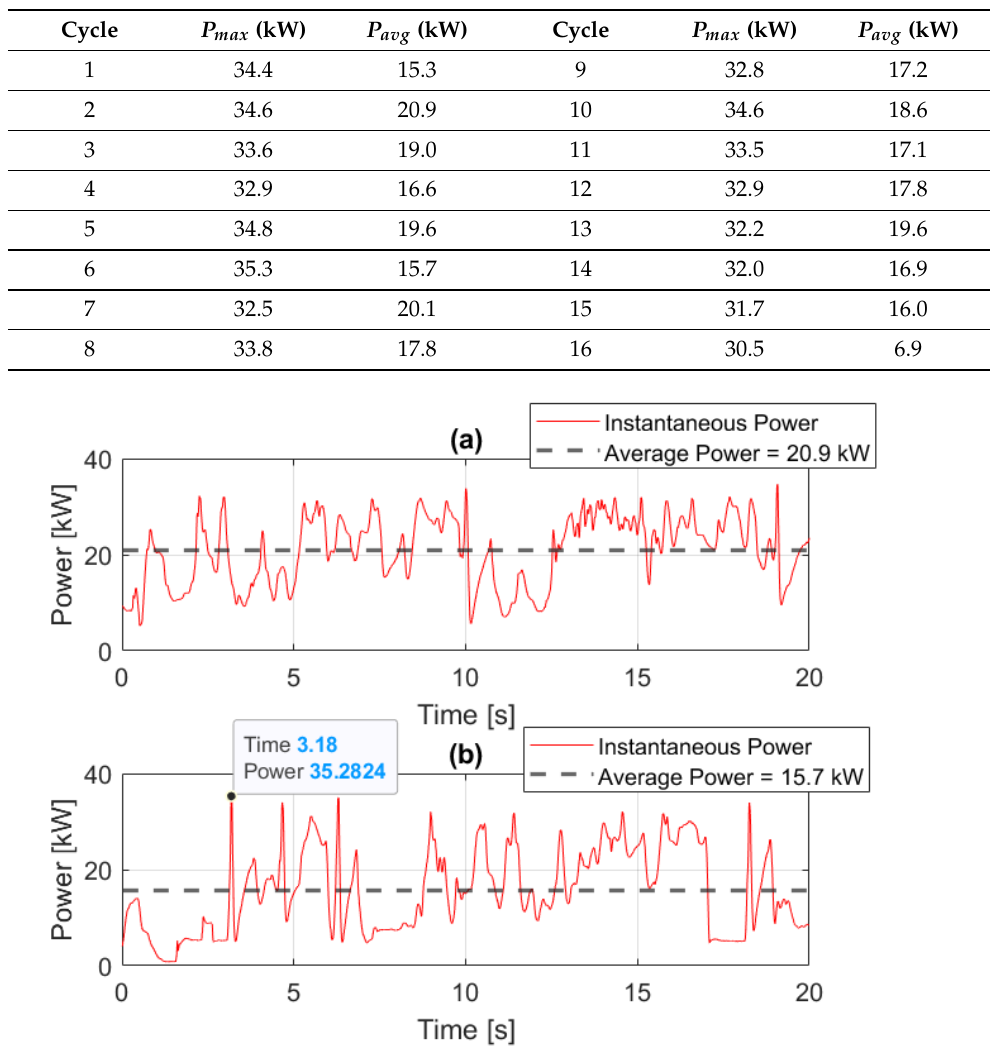
Figure 6. Power demand of the backhoe hydraulic pump in ditch excavation operation. Table 2. Powers during backhoe operating intervals during ditch excavation.